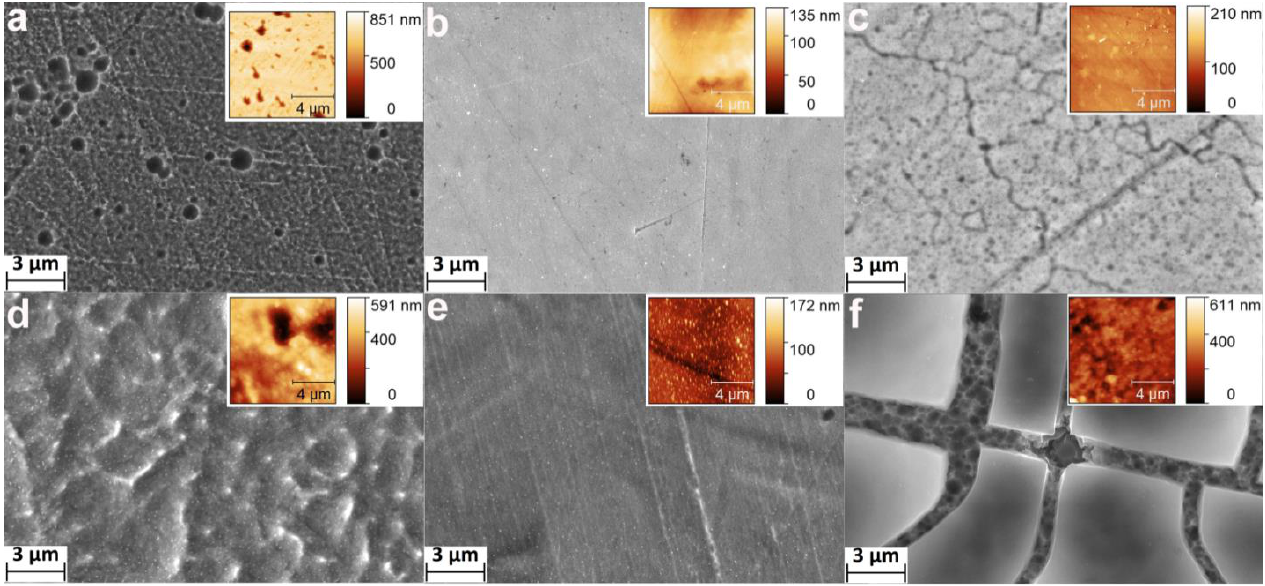
Figure 2. SEM images (3 µm scale bars) of nitinol surface for samples: ( a ) HCl/H 2 SO 4 -30 min, ( b ) H 2 SO 4 /H 2 O 2 -30 min, ( c ) NH 4 OH/H 2 O 2 -30 min, ( d ) HCl/H 2 SO 4 -120 min, ( e ) H 2 SO 4 /H 2 O 2 -120 min, ( f ) NH 4 OH/H 2 O 2 -120 min. The insets show the AFM surface topographies of the corresponding samples.